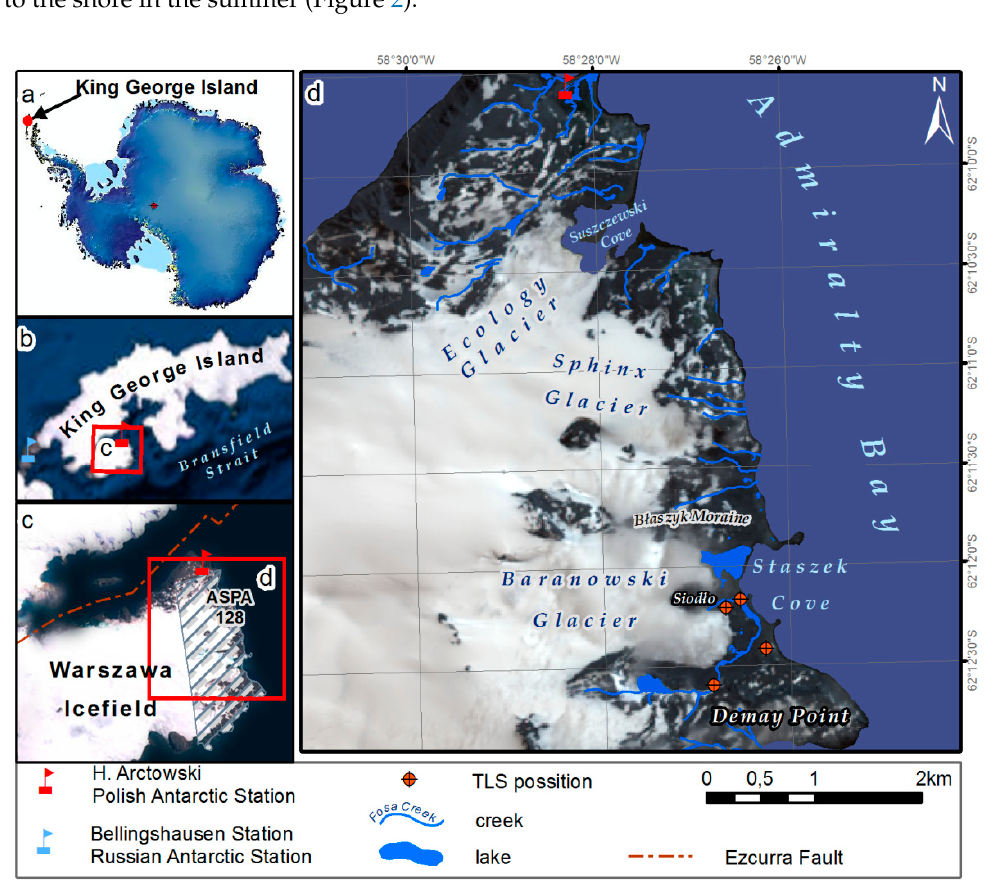
Figure 2. Location of the study area: ( a ) Antarctica; ( b ) King George Island (KGI); ( c ) Warszawa Icefield; ( d ) Western shore of Admiralty Bay. Basemap: Landsat (18 January 2014). Reference system: World Geodetic System (WGS) 1984, Universal Transverse Mercator (UTM) zone 21S, geoid Earth Gravitational Model 1996 (EGM96).